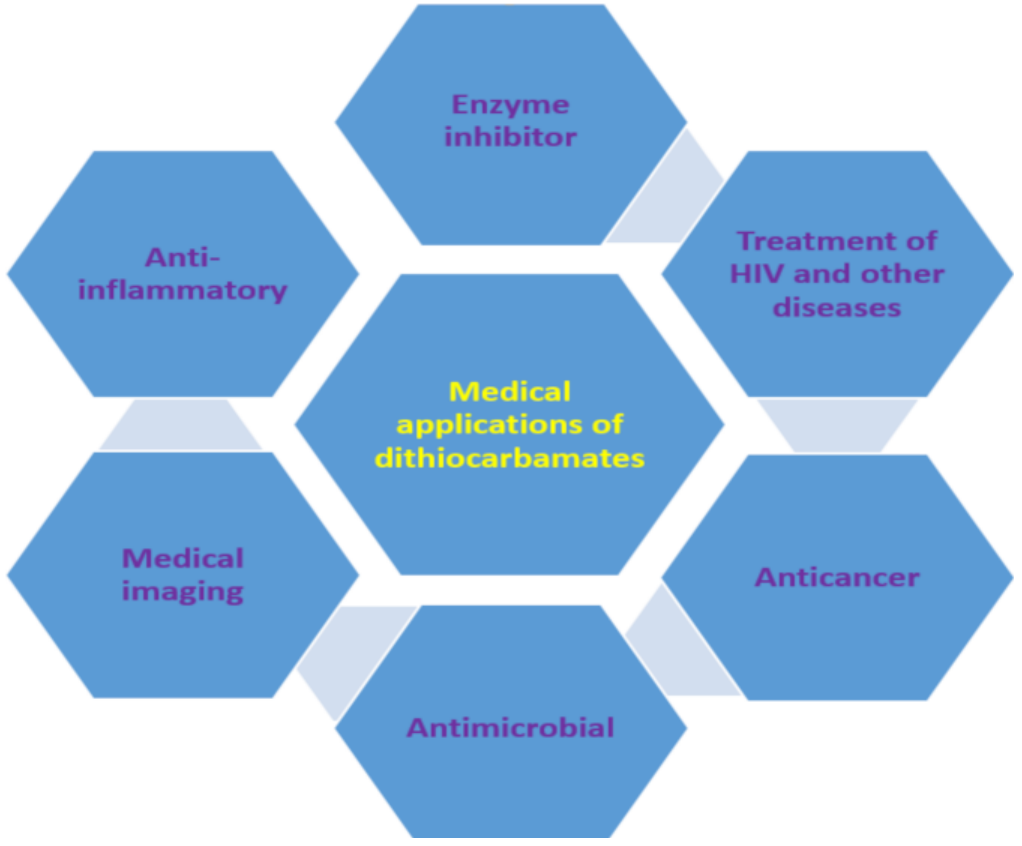
Figure 8. Medical applications of dithiocarbamate